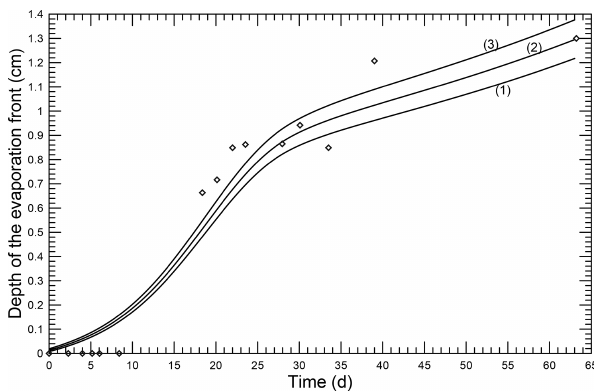
Figure 4. Evaporation front motion. (cid:5) : measured positions, solid lines: numerical simulations. (1) c f = 2 . 27 × 10 − 5 , c e = 9 . 35 × 10 − 6 , (2) c f = 2 . 41 × 10 − 5 , c e = 9 . 94 × 10 − 6 , (3) c f = 2 . 56 × 10 − 5 , c e = 1 . 06 × 10 − 5 , all in grams per cubic centimeter.